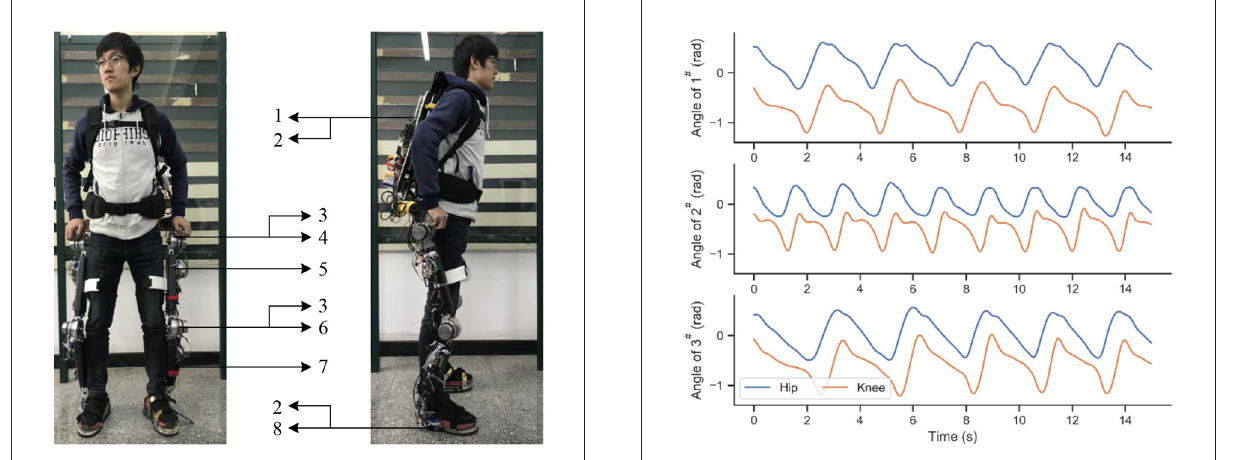
FIGURE3 The hardware system of HEXO exoskeleton. 1. Backpack; 2. SFS; 3. Encode and torque sensor; 4. Hip joint; 5. IMU; 6. Thigh limb; 7. Knee joint; 8. Calf limb.